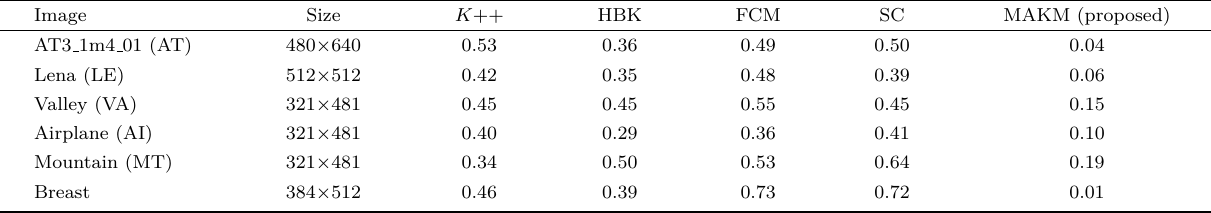
Table 5 Comparison of proposed algorithm with K ++, HBK, FCM, and SC in terms of mean Q -value for AT, LE, VA, AI, MT, and Breast